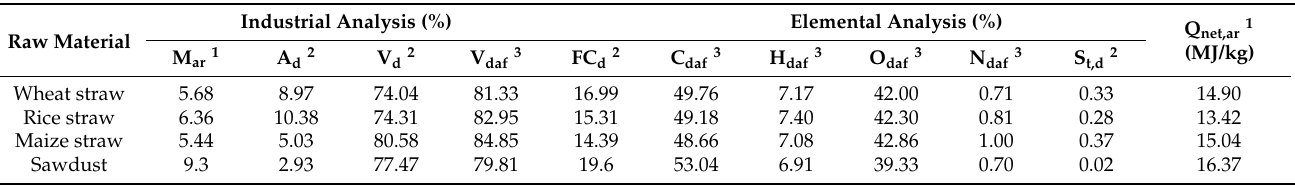
Table 1. Quality information obtained by proximate analysis, elemental analysis, and net calorific value of biomass for tested samples in this